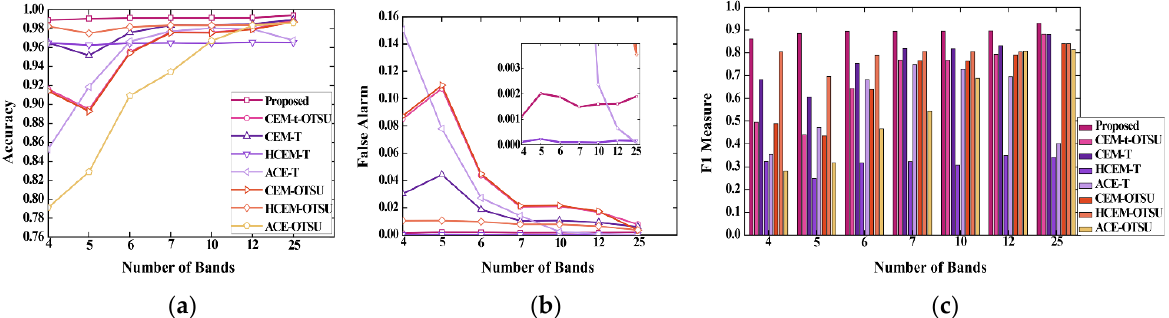
Figure 13. The quantitative comparison of the ASRC-net detection results in the BT scene. ( a ) The curves of A C obtained using different methods; ( b ) The curves of F a obtained using different methods. ( c ) The histograms of F 1 obtained using different methods.